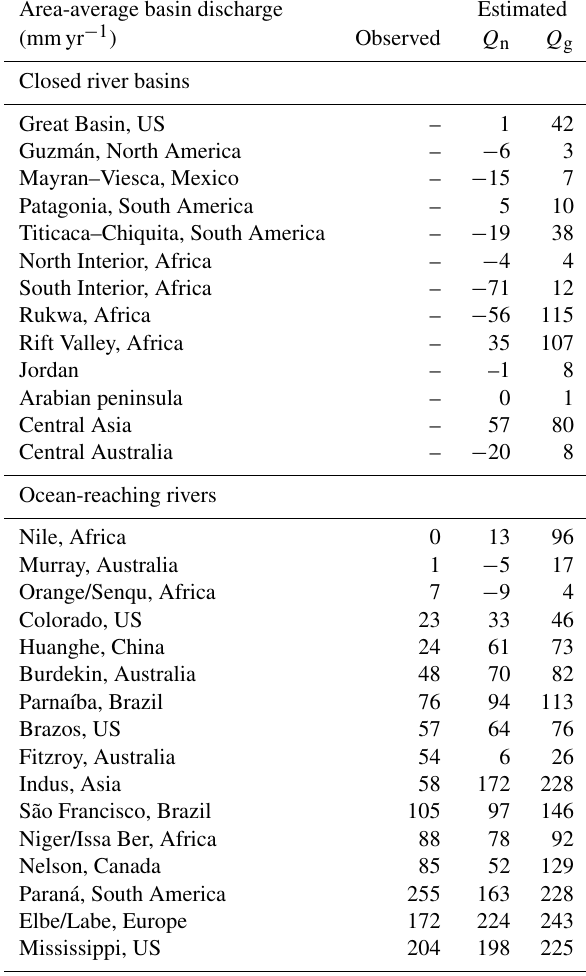
Table 2. Irrigation water withdrawal ( W) as reported to FAO for the 20 countries with largest agricultural withdrawals, along with the estimated minimum field-level irrigation requirement ( I 0 ) , the co- ) and the apparent project efficient of variation in I 0 estimates (CV I 0 efficiency ( I 0 /W)